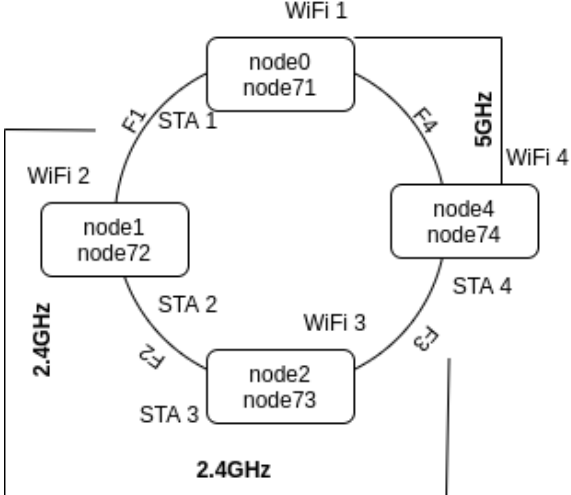
Figure 13. CityLab ring topology node setup.